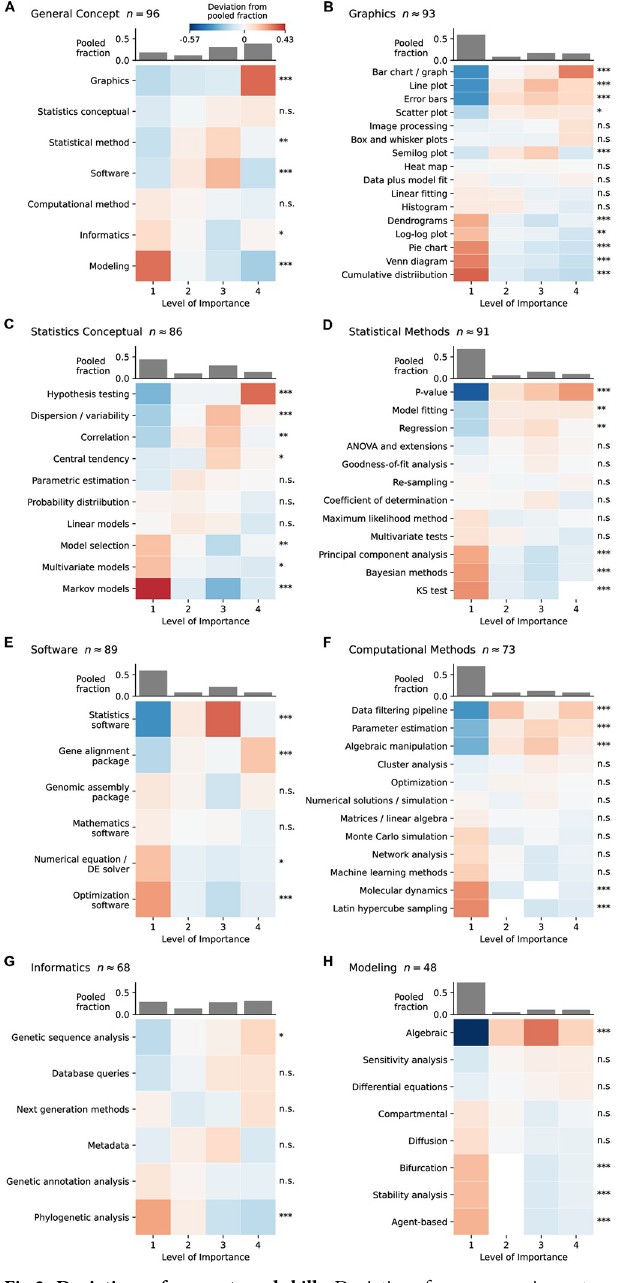
Fig 3. Deviations of concepts and skills. Deviations from average importance distributions for concepts (A) and skills (B to H) identified from solicited papers. Importance ranges from 1 = Concept not in this article to 4 = Very important to understanding this article, as in Fig 2. Significant deviation from expected fraction is as follows: n.s. p > 0.05;